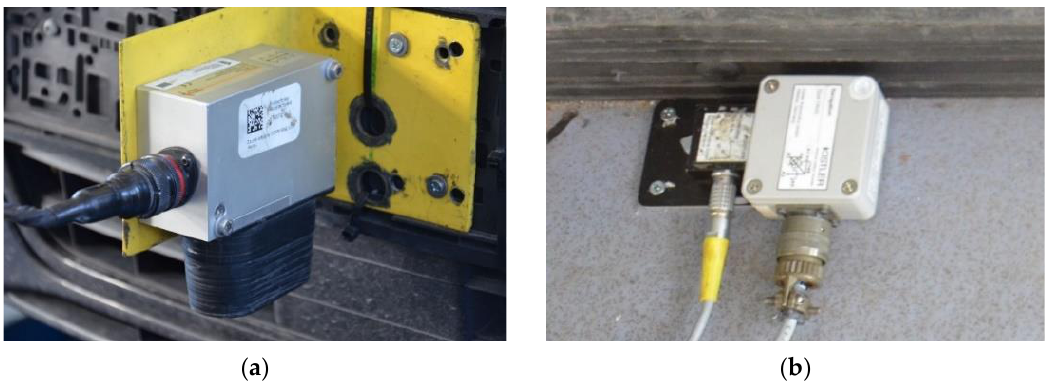
Figure 1. Testing equipment used in the tests: ( a ) Datron ® S-350 optoelectronic sensor, ( b ) 3-axis TAA™ and TANS™ sensors.